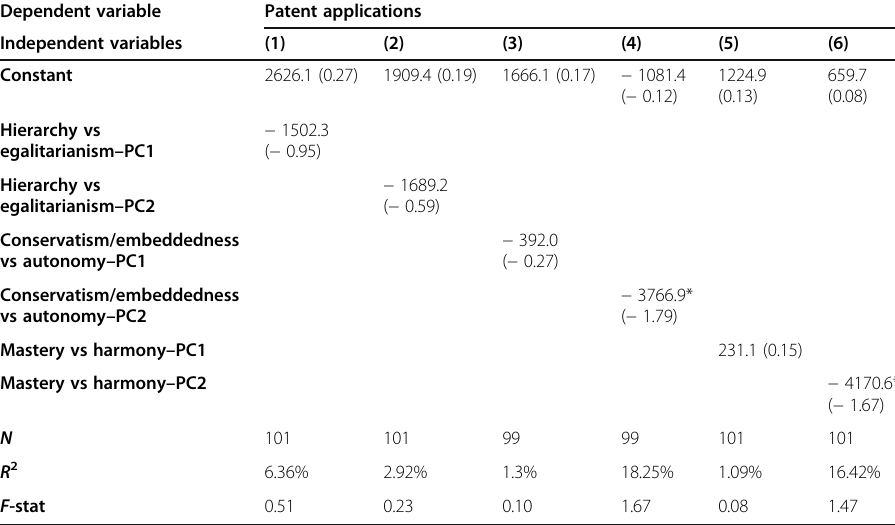
Table 10 The effect of culture on patent applications